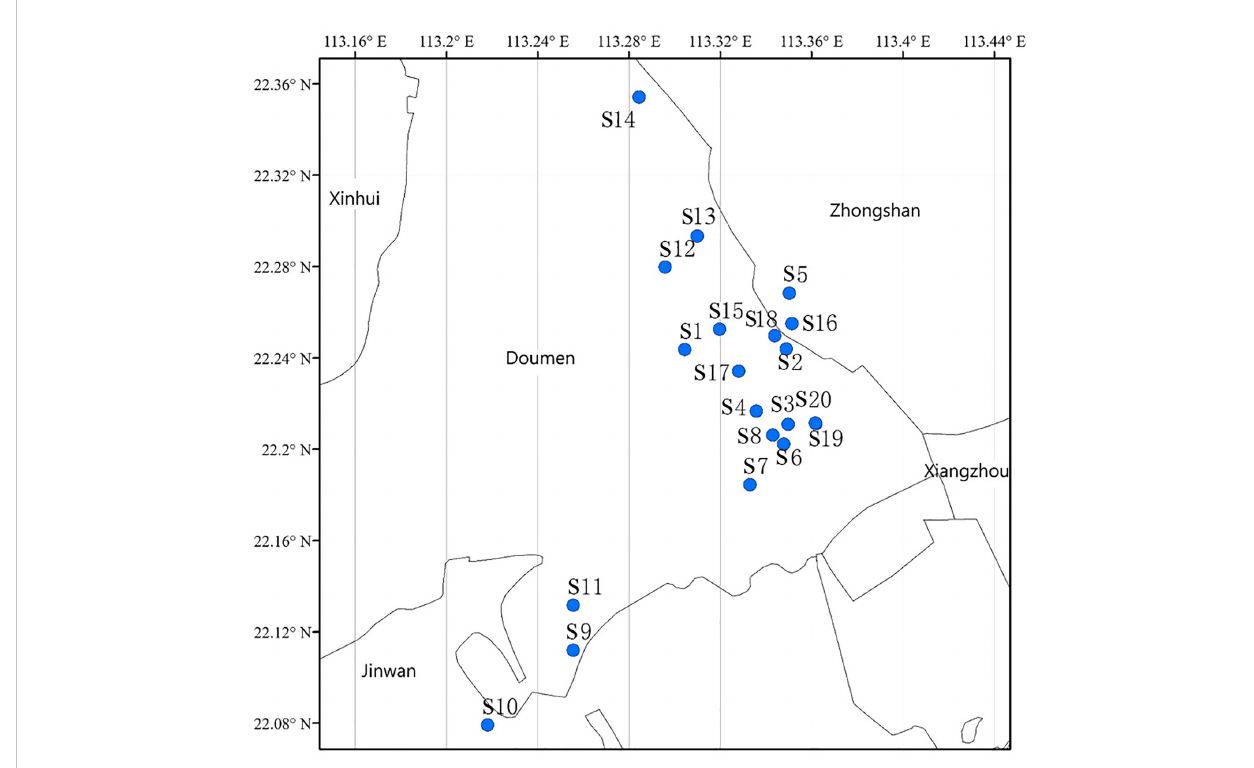
FIGURE 1 Sampled ponds (S1 – S20) in the sea bass aquaculture area in Zhuhai,